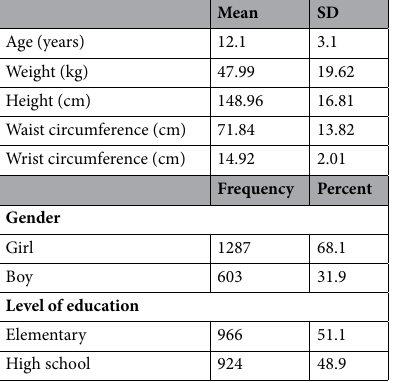
Table 1. Demographics and anthropometry information of the